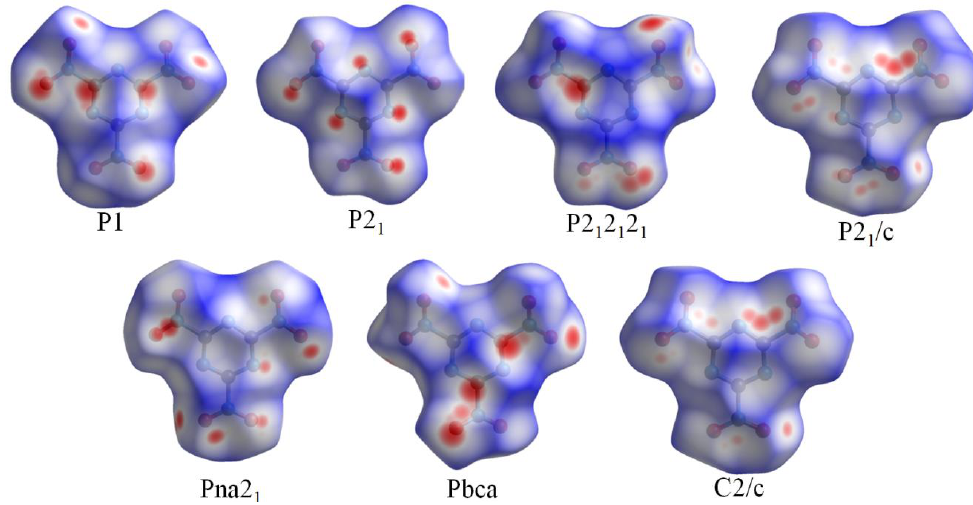
Figure 3. Hirshfeld surfaces of seven space groups in crystal stacking.